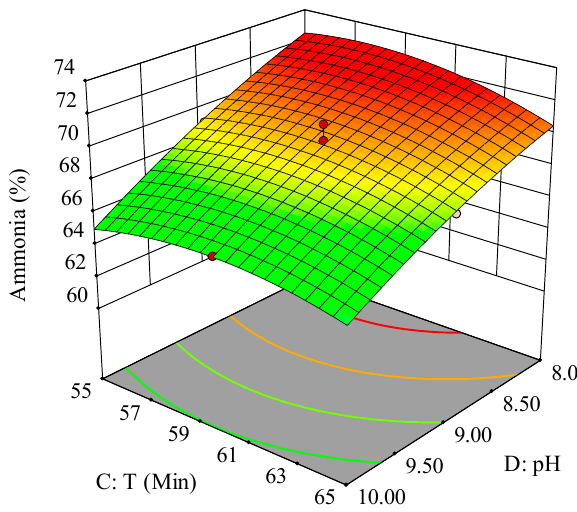
Figure 5. 3D surface plots for removal of ammonia on influences of current density and pH.